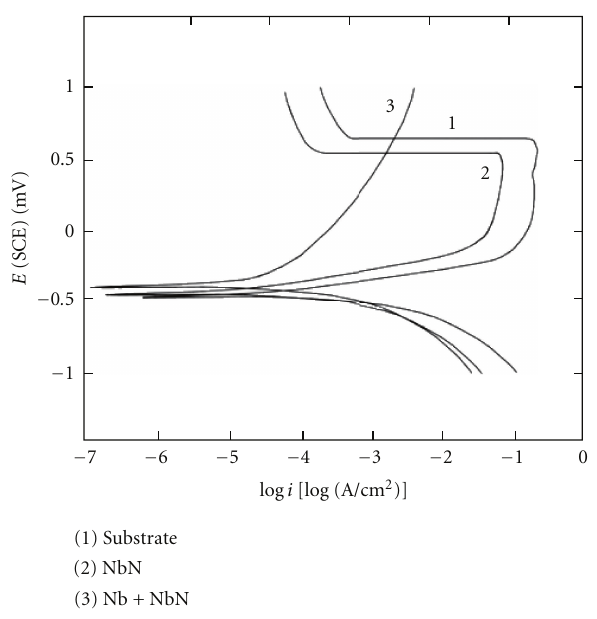
Figure 12: Potentiodynamic curves for MS, NbN/MS and NbN/